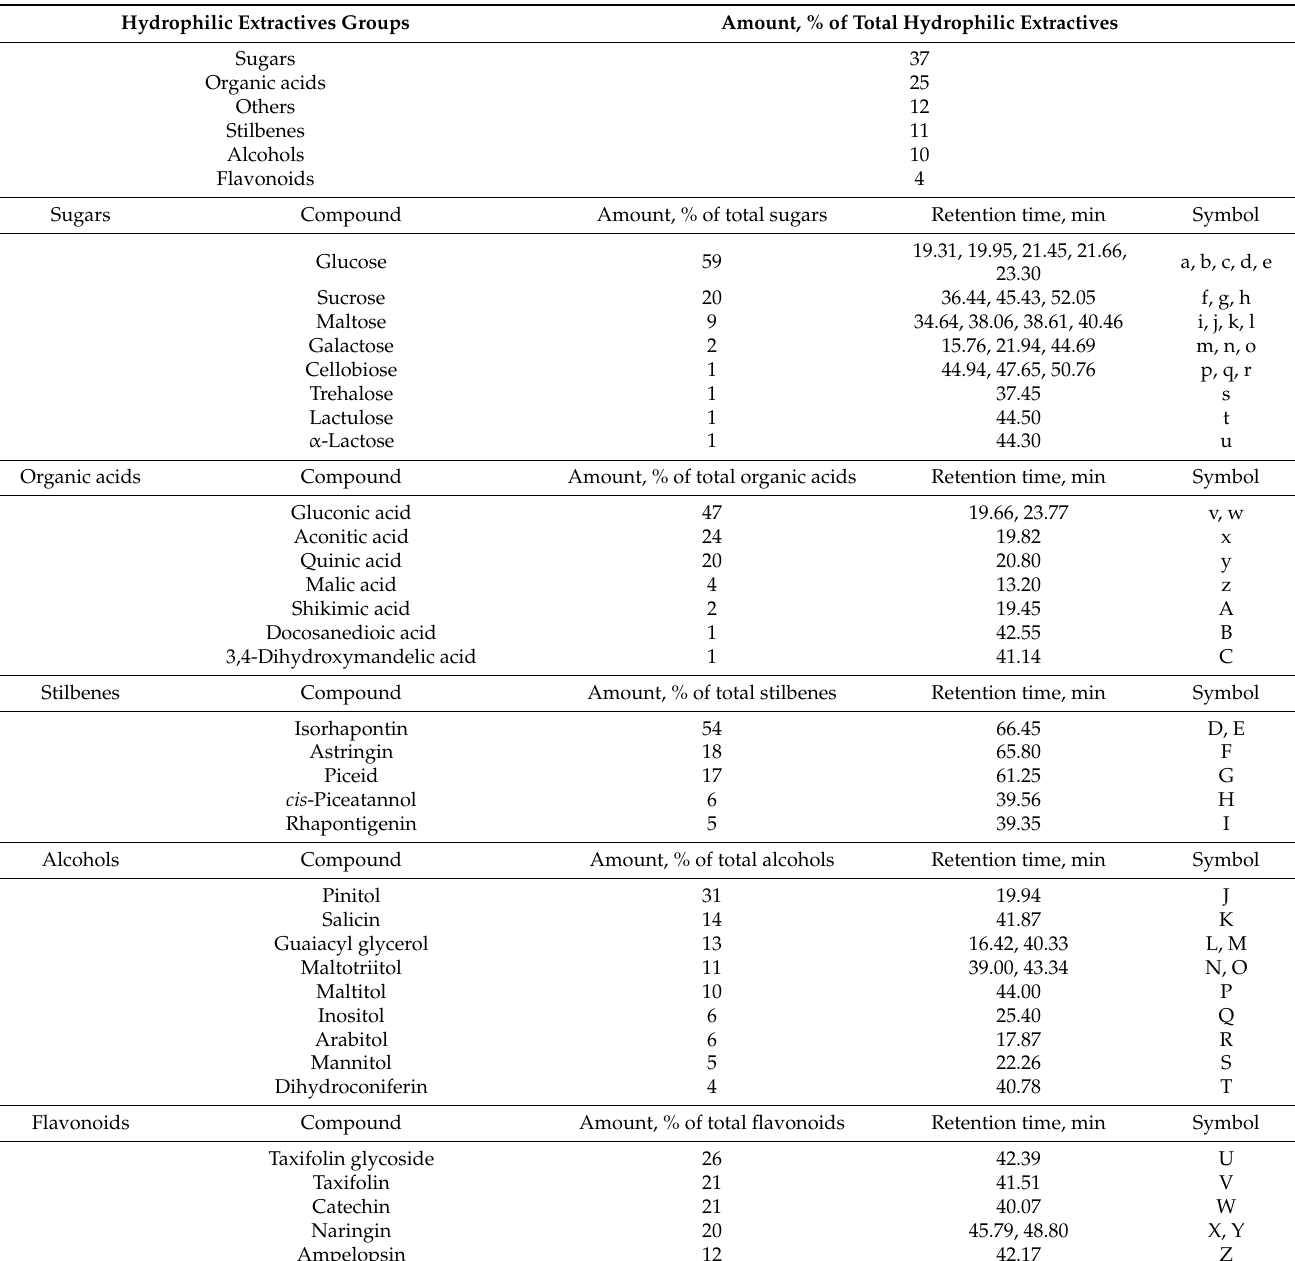
Table 4. The primary spruce bark hydrophilic extractives identified via gas chromatography-mass spectrometry (GC-MS). Hydrophilic Extractives